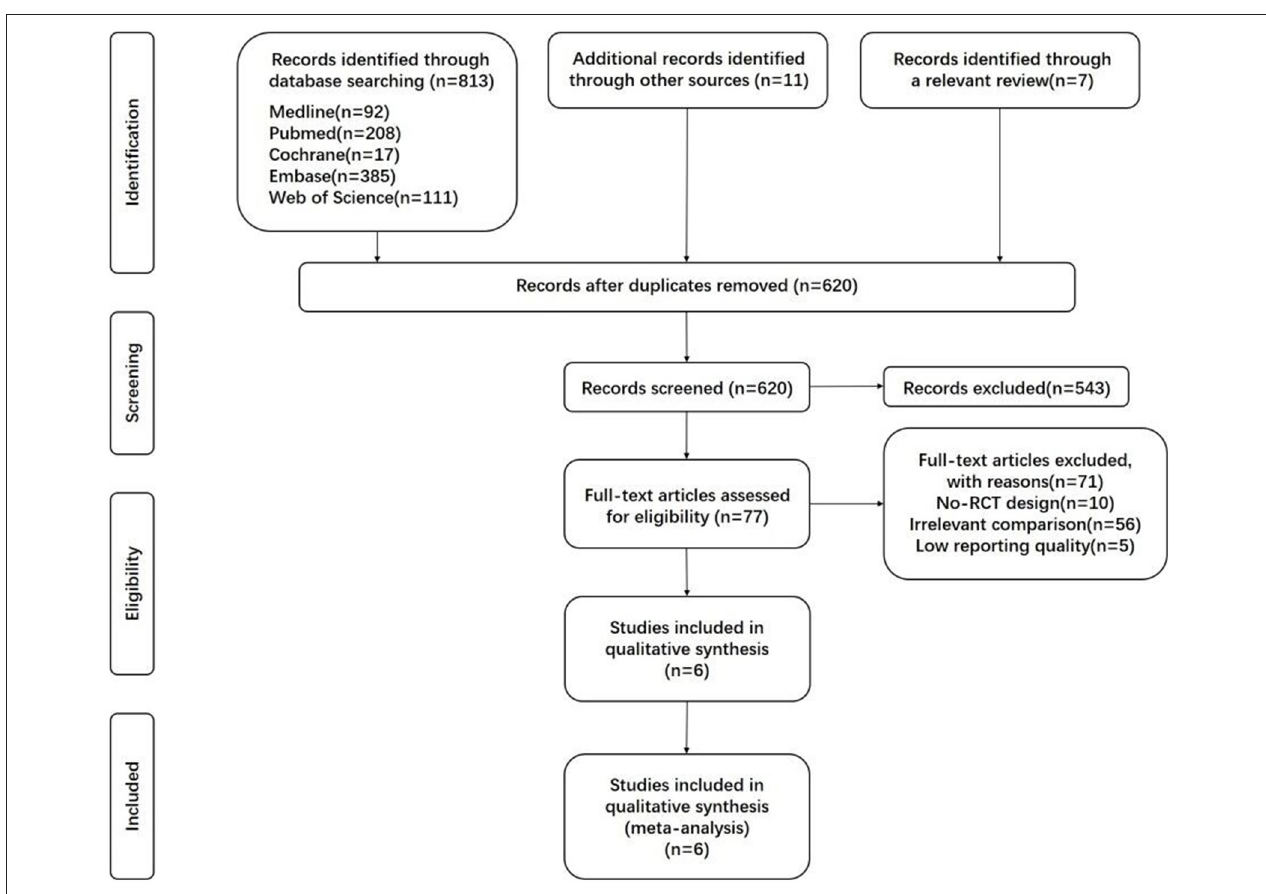
FIGURE 1 | PRISMA flowchart for study